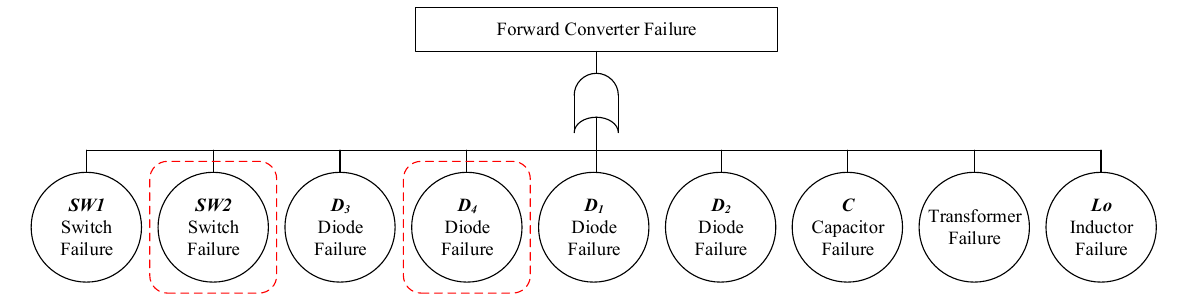
Figure 3. Failure dependency in the forward converters.